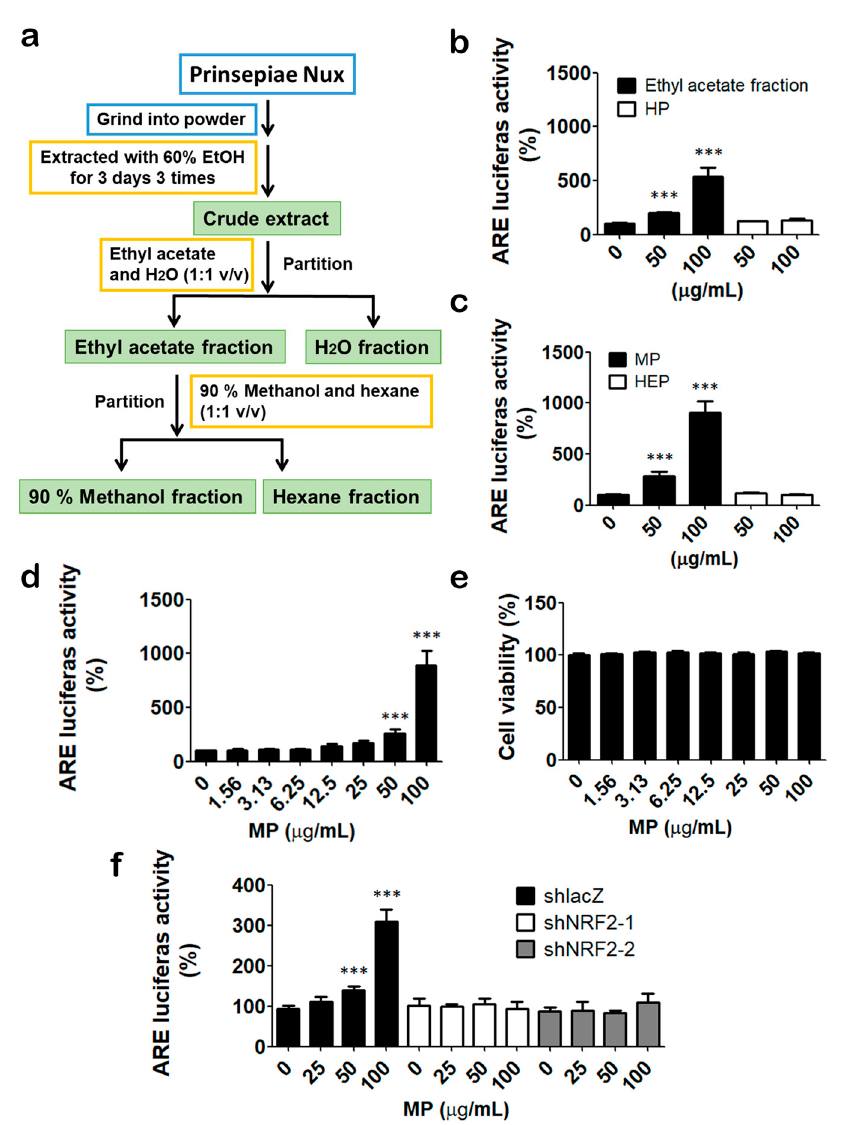
Figure 1. Prinsepiae Nux fraction increased NRF2 activity. ( a ) Flowchart of solvent partition. ( b , c ) HaCaT/ARE cells were treated with extracts from ethyl acetate fraction, H 2 O-partitioned (HP) fraction, 90% methanol (MP) fraction, and n-hexane (HEP) fraction for 18 h for reporter assay. ( d ) HaCaT/ARE cells were treated with indicated concentrations of MP fraction for 18 h for reporter assay. ( e ) HaCaT cells were treated with indicated concentrations of MP fraction for 72 h for cell viability assay. ( f ) Control (shLacZ) and NRF2 knockdown (shNRF2-1 and shNRF2-2) cells were treated with MP fraction for 18 h for reporter assay. DMSO solvent control was used as 100%. Data are presented as mean ± SD from three independent experiments. The asterisk (*) indicates a significant difference from the solvent control cells. (*** p < 0.001, one-way ANOVA).